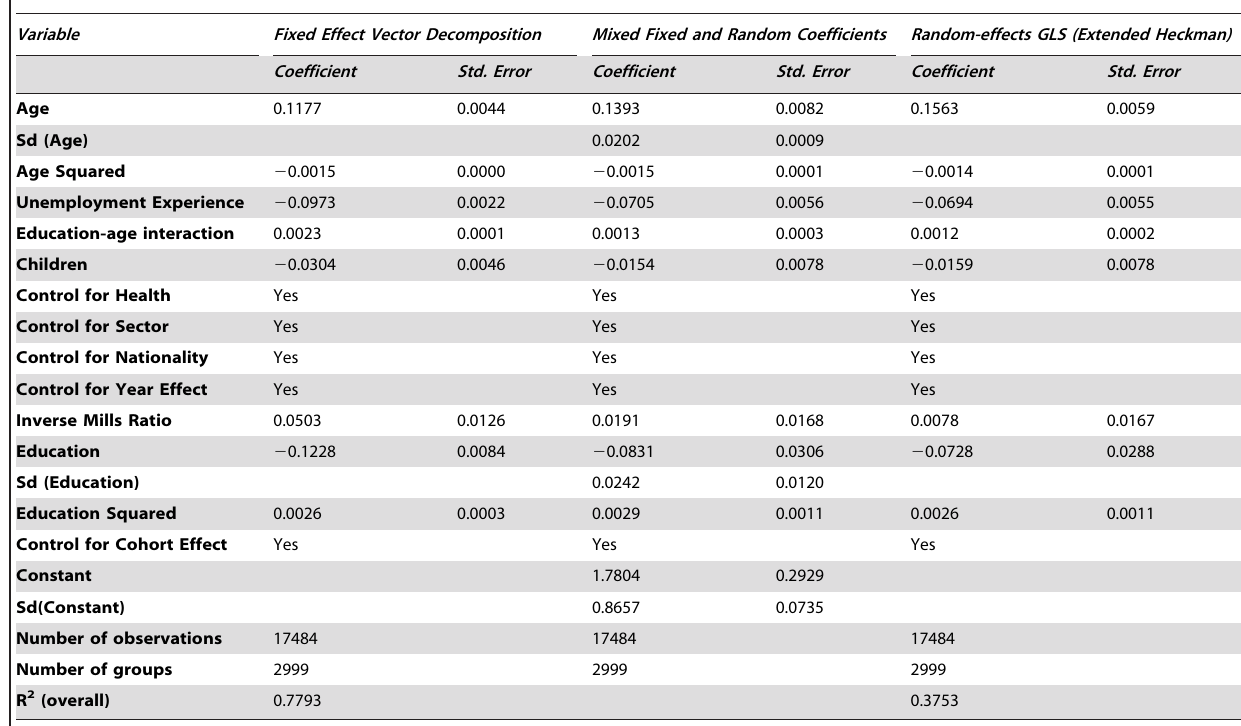
Table 4. Wage Function Estimates for Men